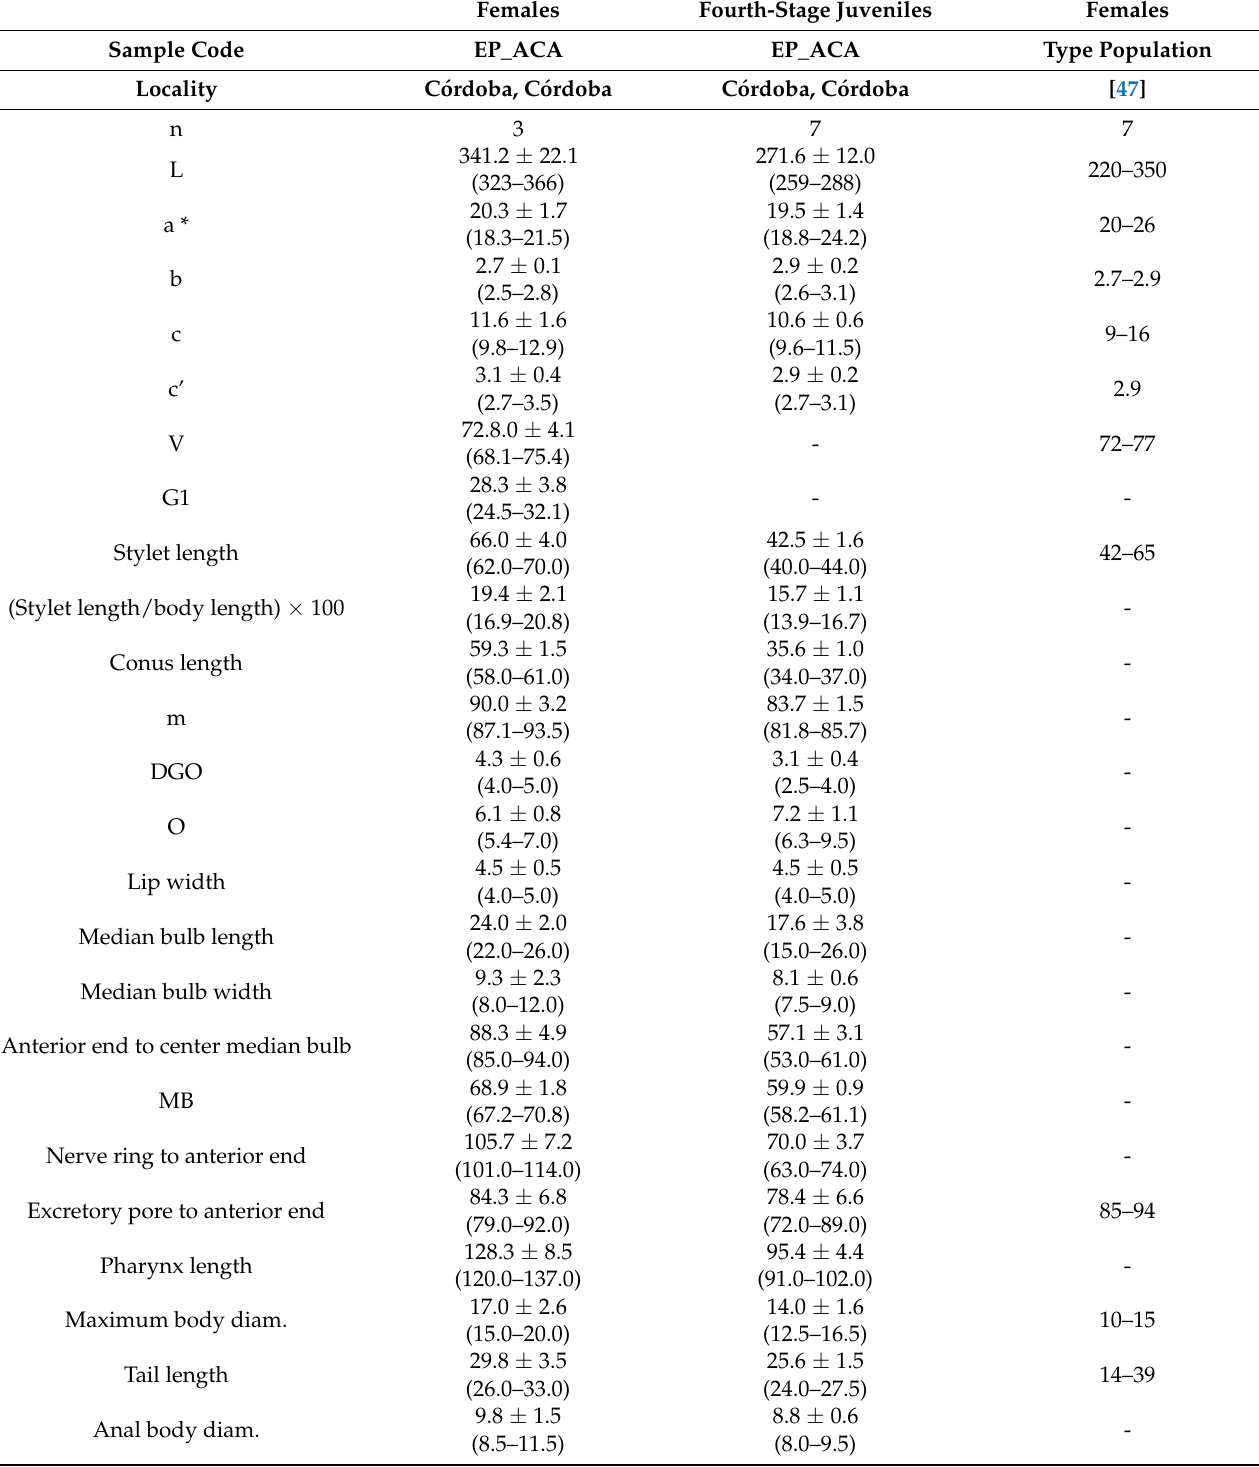
Table 13. Morphometrics of Paratylenchus vitecus (Pramodini et al., 2006) Ghaderi et al., 2014 from C ó rdoba, C ó rdoba, Spain. All measurements are in µ m and in the form: mean ± s.d.